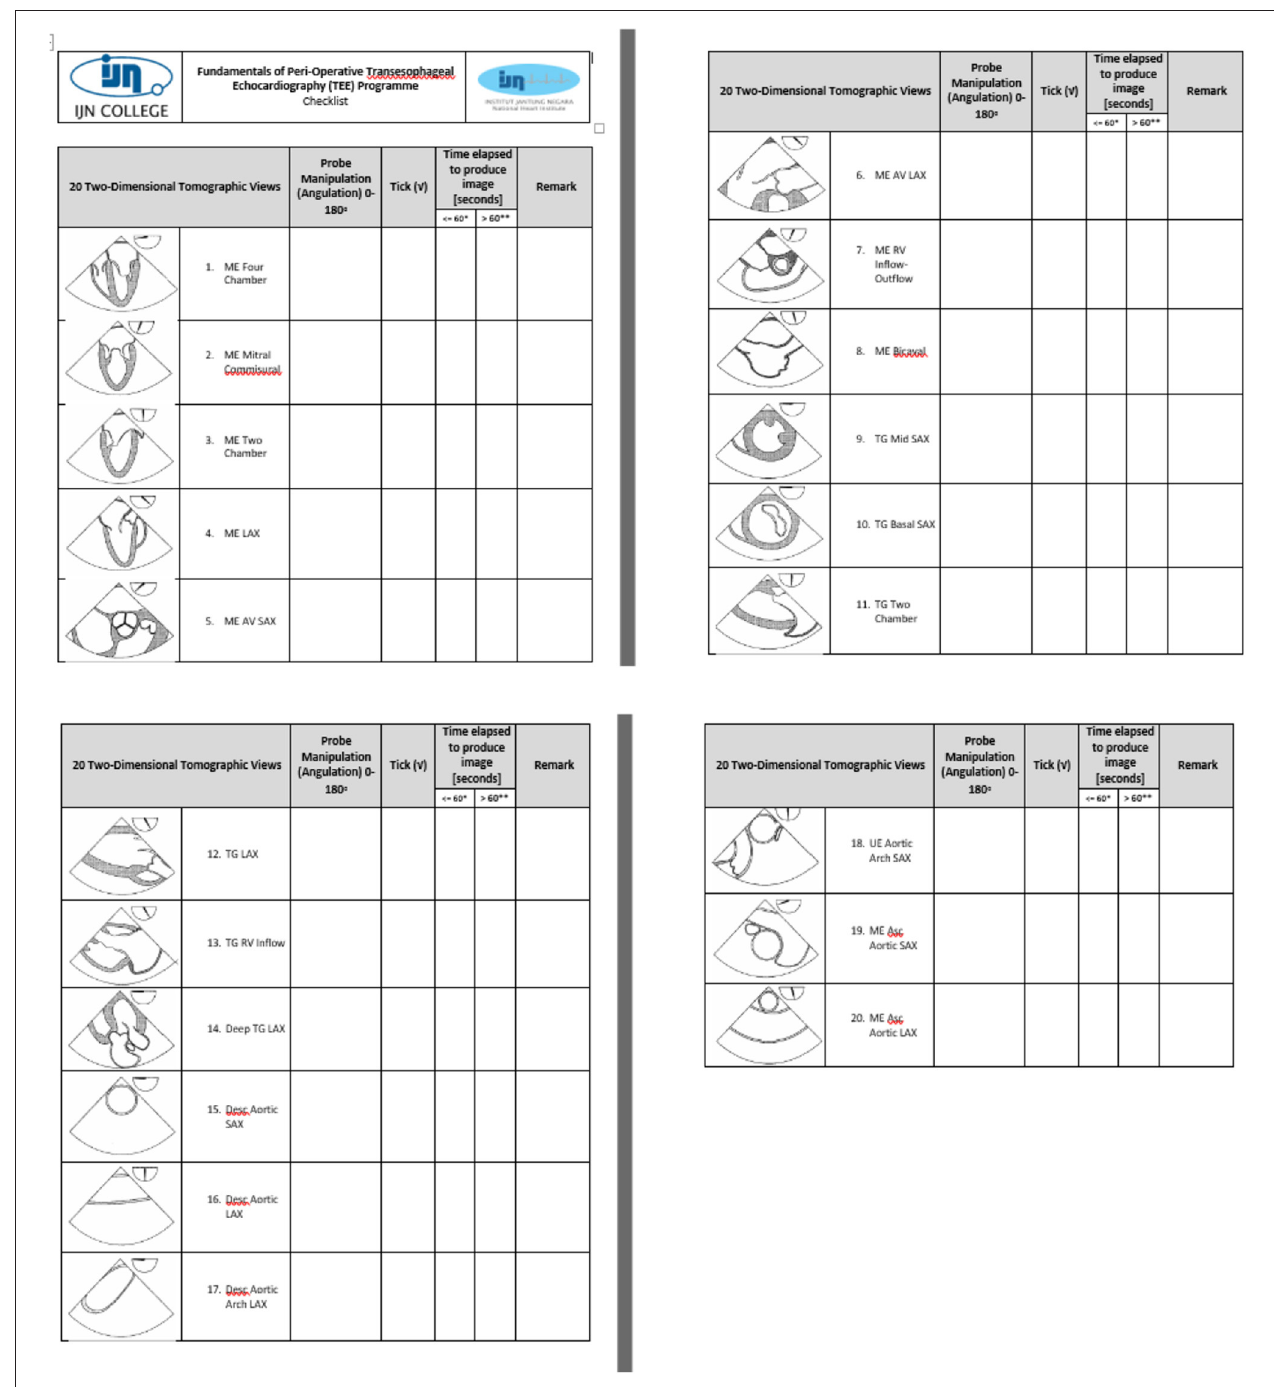
FIGURE 4 | The element of time in the learning outcome of all 20 views: acquisition within 20min for the fourth cohort in 2016.